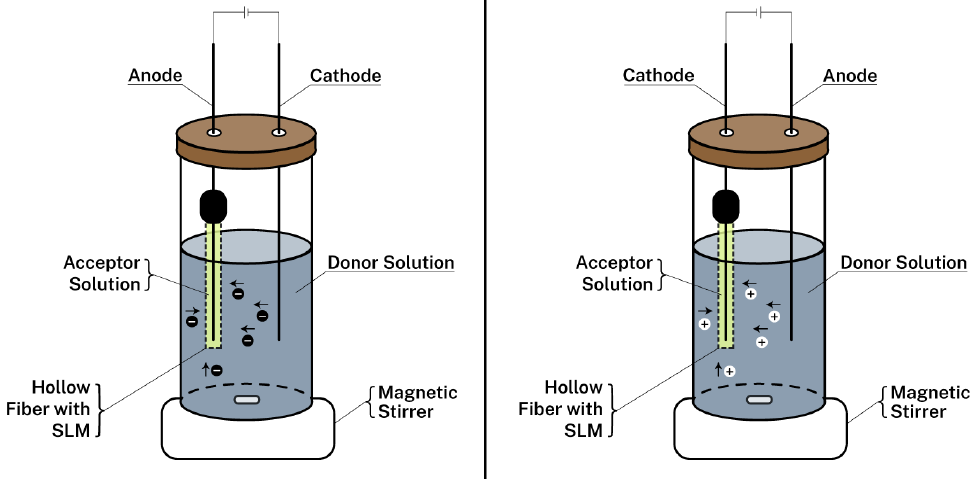
Figure 5. Main elements of the EME technique for the extraction of anions (left) and cations (right). SLM: Supported liquid membrane.